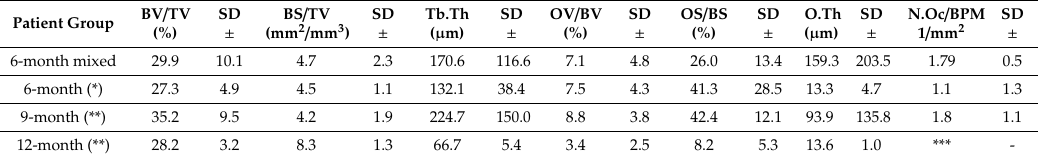
Table 4. Histomorphometric evaluation of the total section: overview of the mean values of the 6-month mixed graft group (autogenous bone mixed with Straumann ® bone ceramic (60:40)) compared to the 6-, 9- and 12-month results with pure Straumann ® bone ceramic (60:40), as previously published, in a maxillary sinus floor elevation